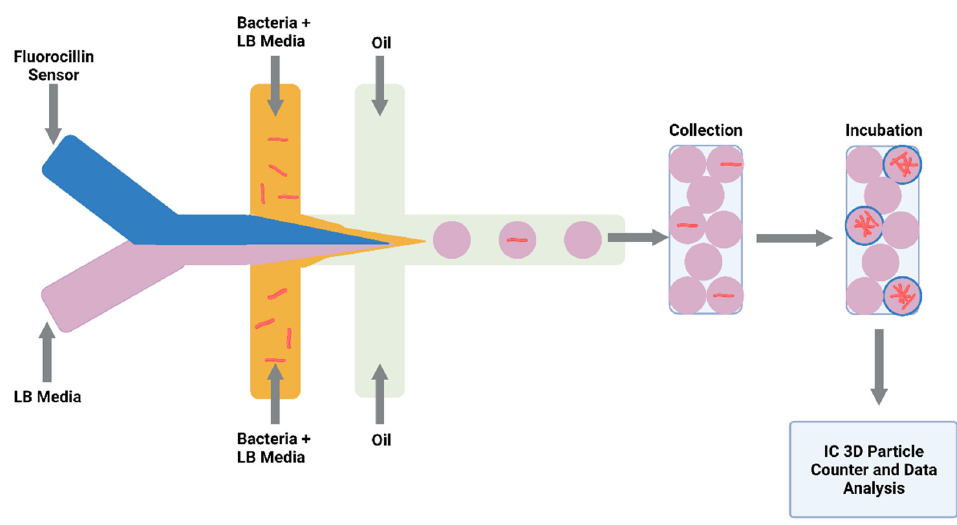
Figure 3. Schematic illustration of droplet system coupled to an Integrated Comprehensive Droplet Digital Detection. Flow-focusing microfluidic chip geometry producing encapsulated mycobacteria in droplets. Figure created on Biorender.com, accessed on 26 October 2021.